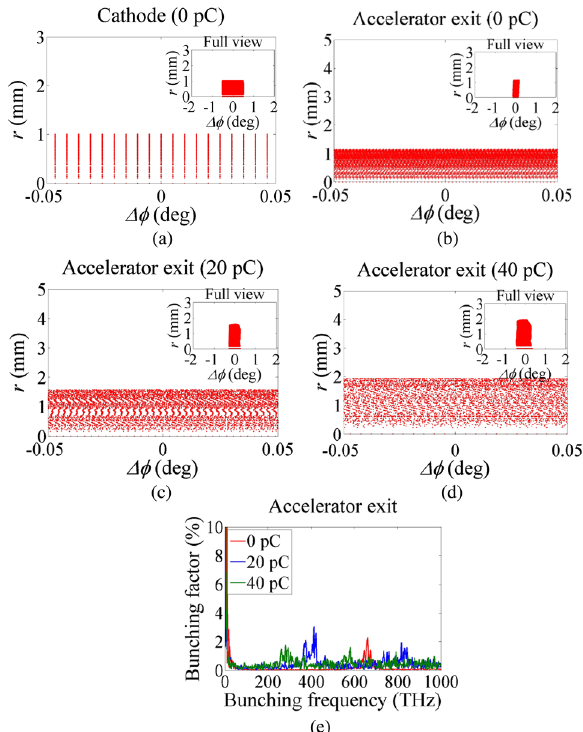
FIG. 5. (a) Δ ϕ − r distribution of an electron-pulse train with an initial bunching frequency of 200 THz at the cathode. Δ ϕ − r distributions of the electron-pulse trains with total charges of (b) 0 (no space charge), (c) 20, and (d) 40 pC at the exit of the accelerator. (e) Bunching factor spectra of the output electron- pulse trains with total charges of 0, 20, and 40 pC. The space charge field, in addition to the radially dependent acceleration fields, tends to smear out electron microbunches. Off-crest acceleration also introduces slight velocity bunching and shifts the bunching spectrum to higher